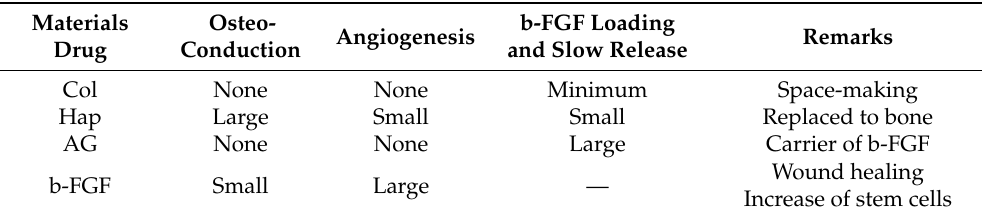
Table 2. Roles of components of the prepared granules (AI Col/Hap/AG) and b-FGF contained